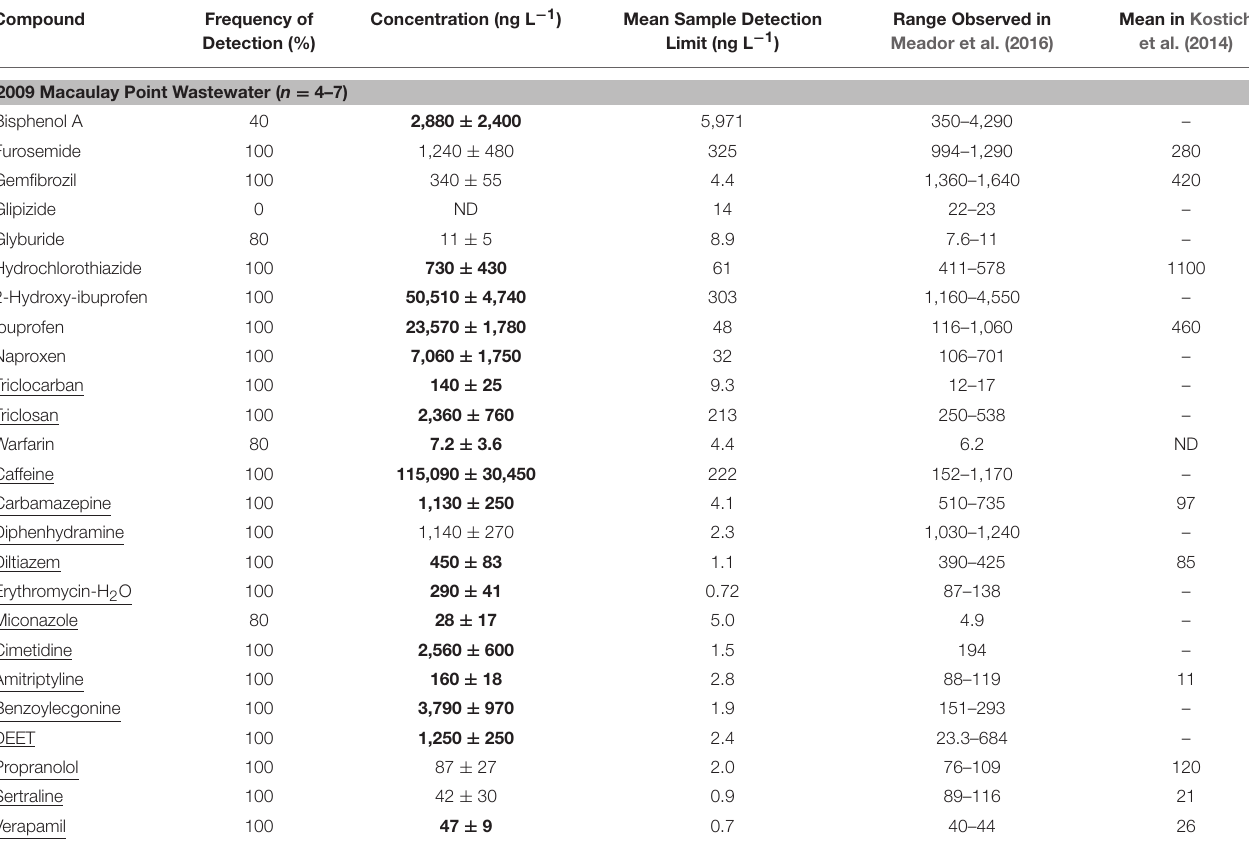
TABLE 3 | Concentration (mean ± standard deviation) of detected PPCPs in MAC wastewater (full results see Lowe 2011) in November 2009.